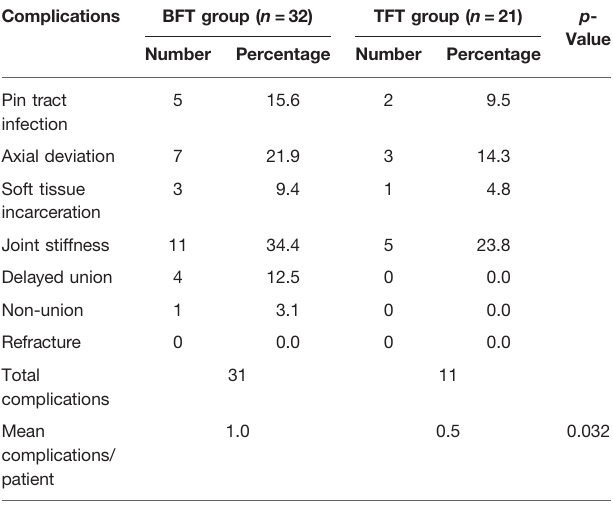
TABLE 3 | Results of ASAMI scores. Parameter Excellent